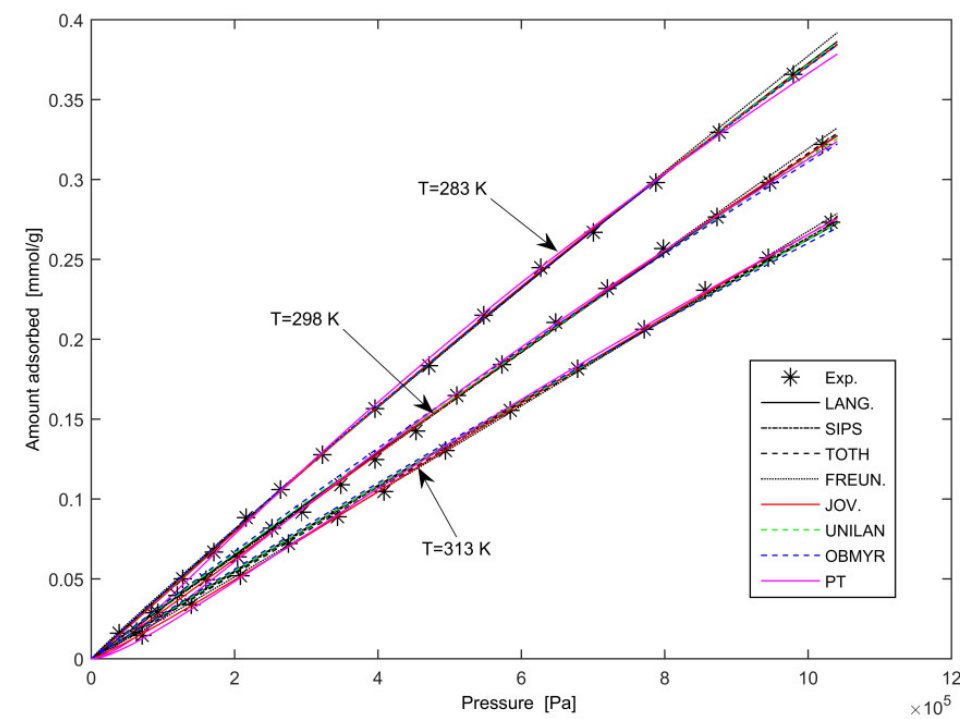
Figure 1. Pure-hydrogen adsorption results on activated carbon JX101.